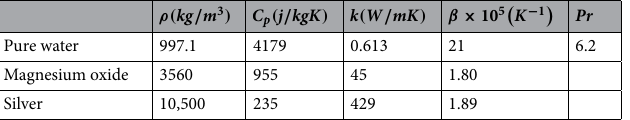
Table 1. The numerical properties of silver, magnesium oxide and water 40,41 .